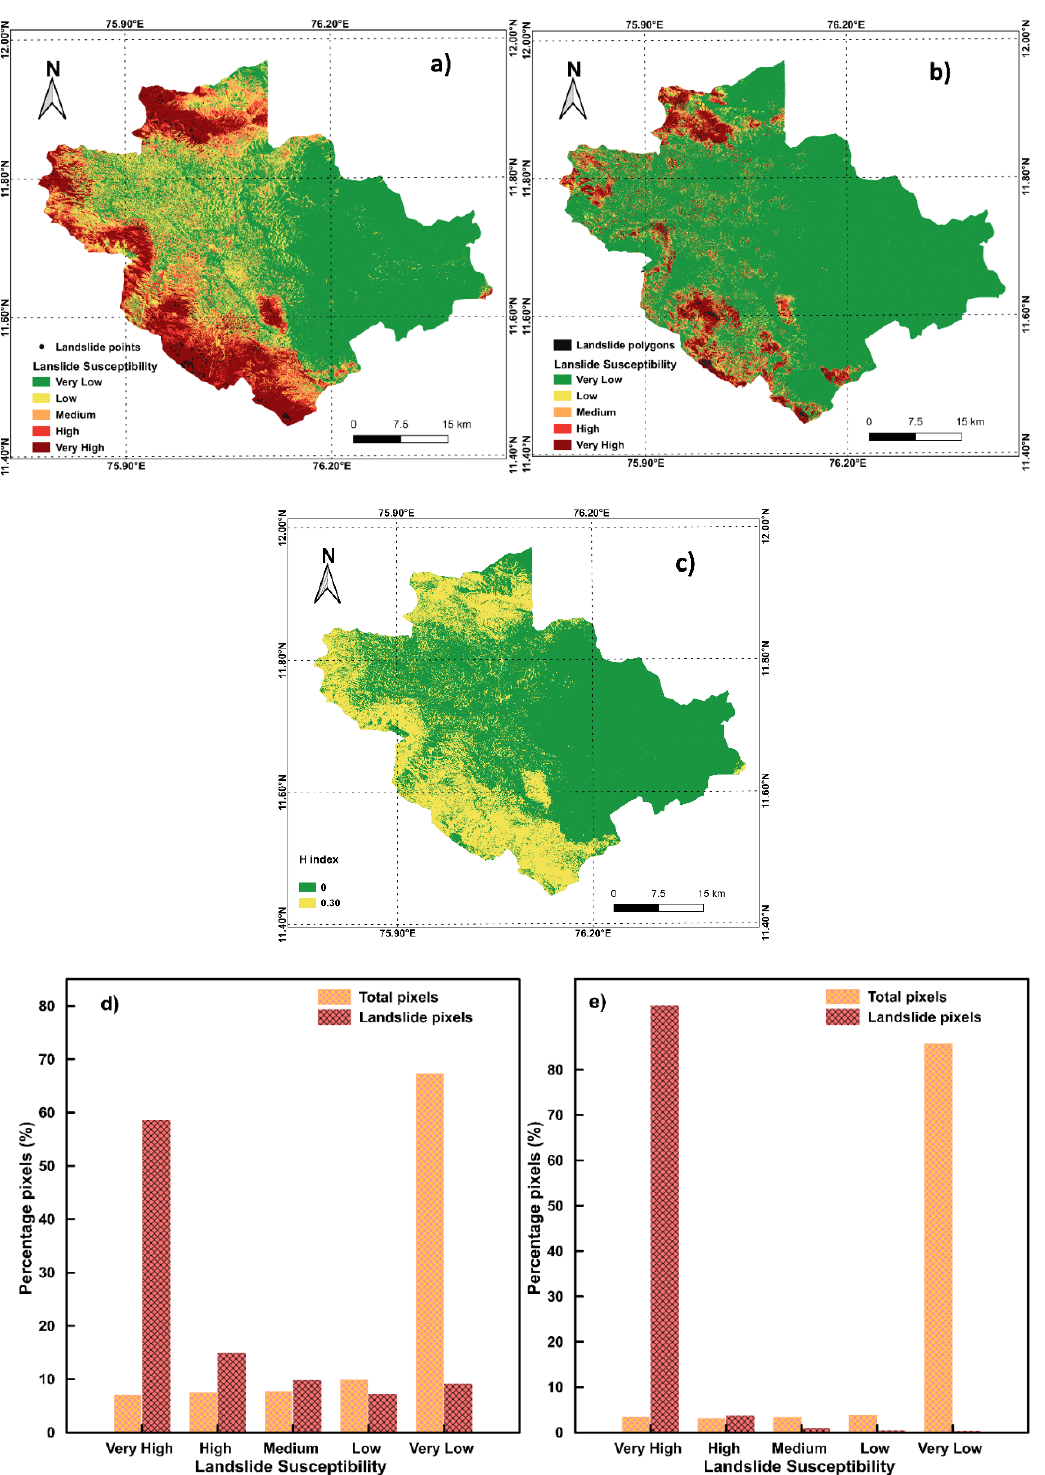
Figure 9. Details of landslide susceptibility maps prepared using KNN algorithm: ( a ) using point data, ( b ) using polygon data, ( c ) H-index plot, ( d ) percentage distribution of pixels using point data, and ( e ) percentage distribution of pixels using polygon data.